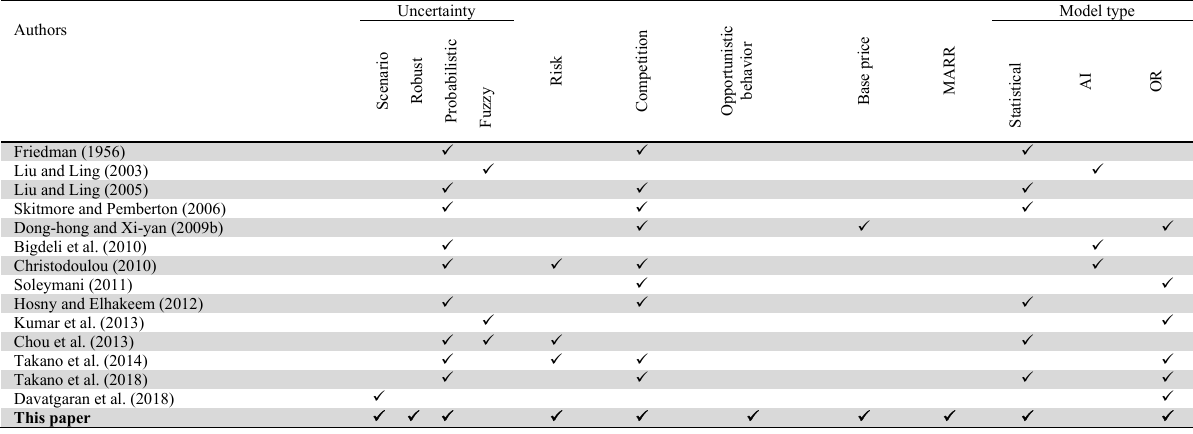
A comparative investigation of the study gap in the